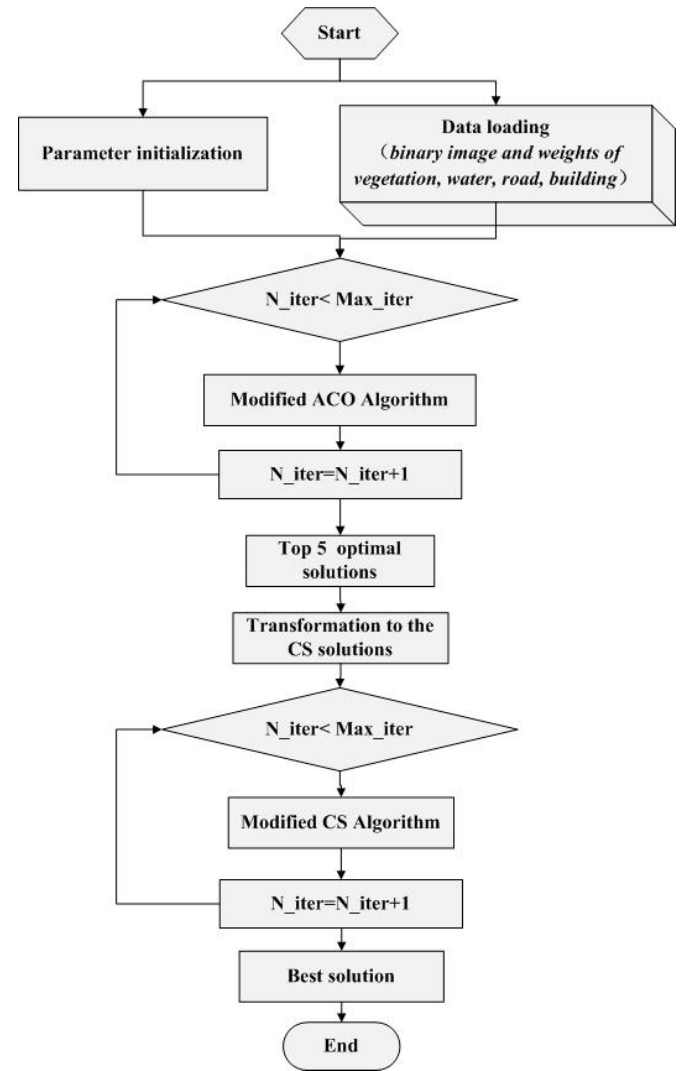
Figure 9. Flowchart of HACCS.